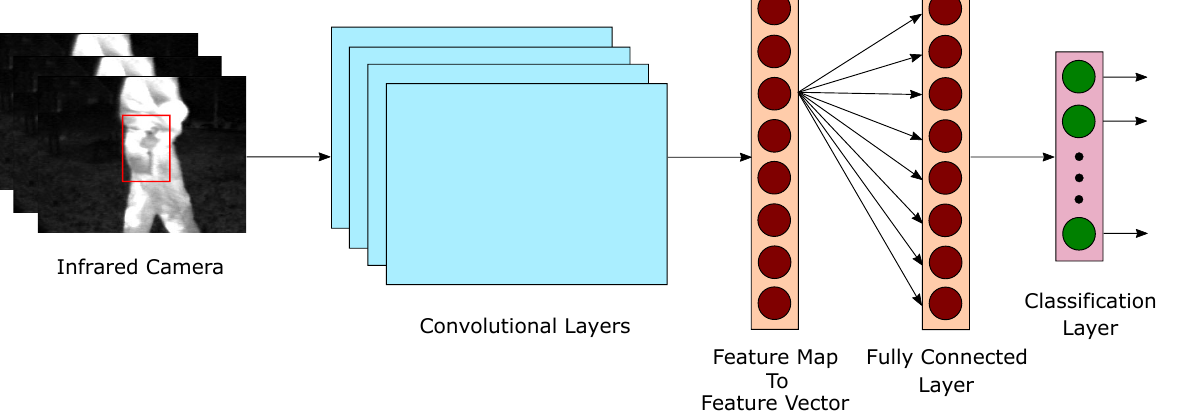
Figure 3. A convolutional neural network (CNN) architecture for automatic object detection and